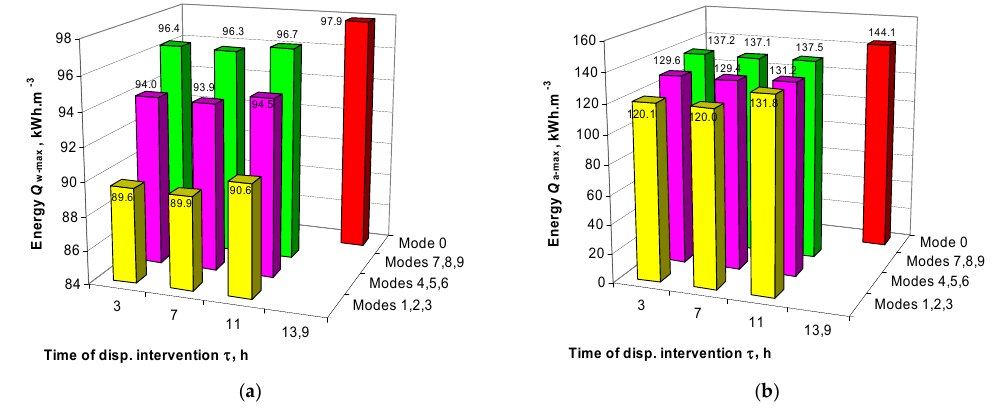
Figure 7. Change in Q w-max ( a ) and Q a-max ( b ) of the studied steaming modes, depending on t m1 and τ . In Figure 8 the change in η of all studied modes is presented.